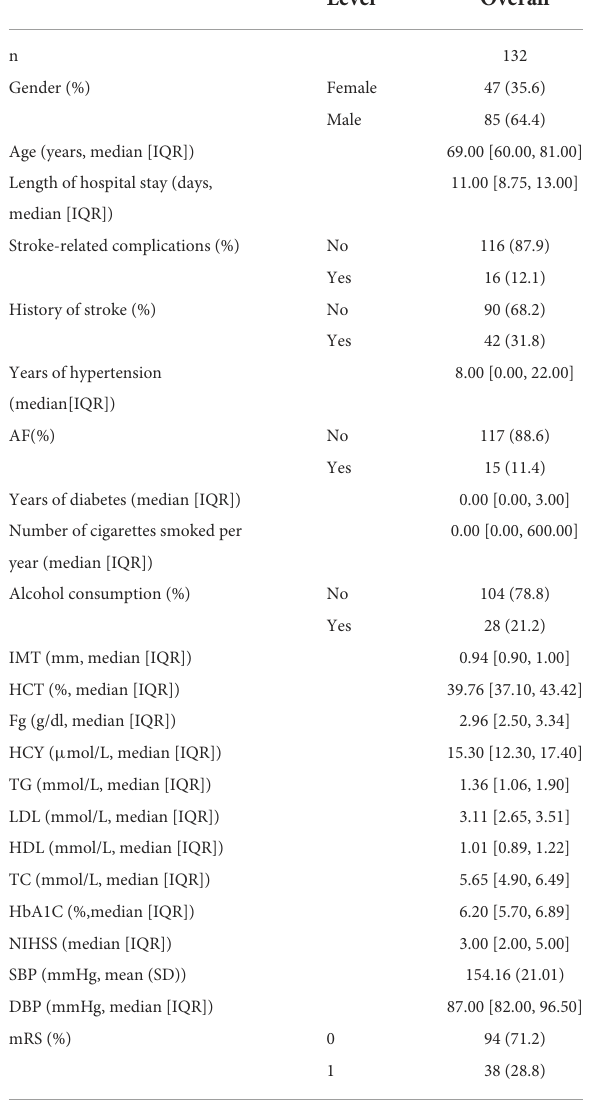
TABLE 1 Baseline characteristics of cohort patients. Level